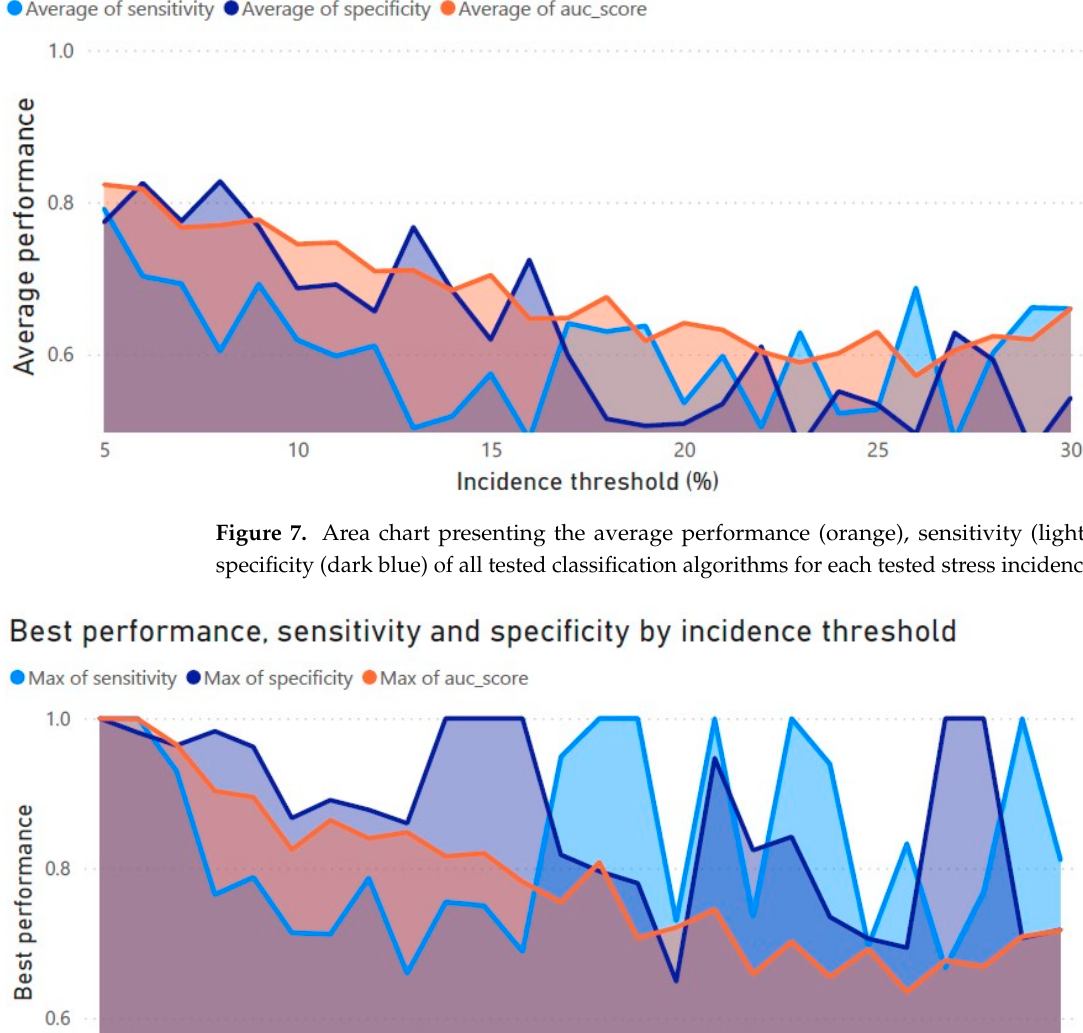
Figure 8. Area chart presenting the best achieved performance (orange), sensitivity (light blue), and specificity (dark blue) among all tested classification algorithms for each tested stress incidence threshold.